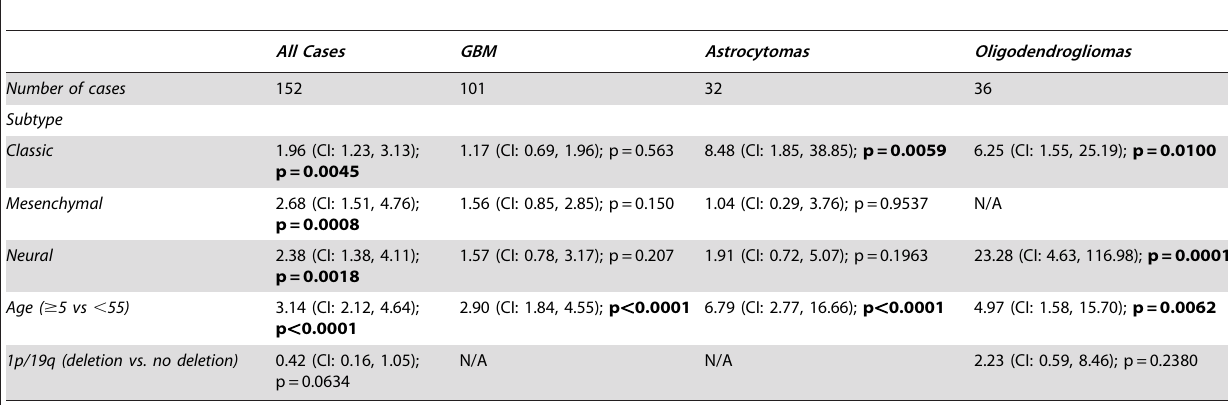
Table 3. Cox proportional hazards (PH) models were used to examine the association between patient survival and four subtypes after adjusting for patient age at diagnosis as well as 1p/19q status whenever